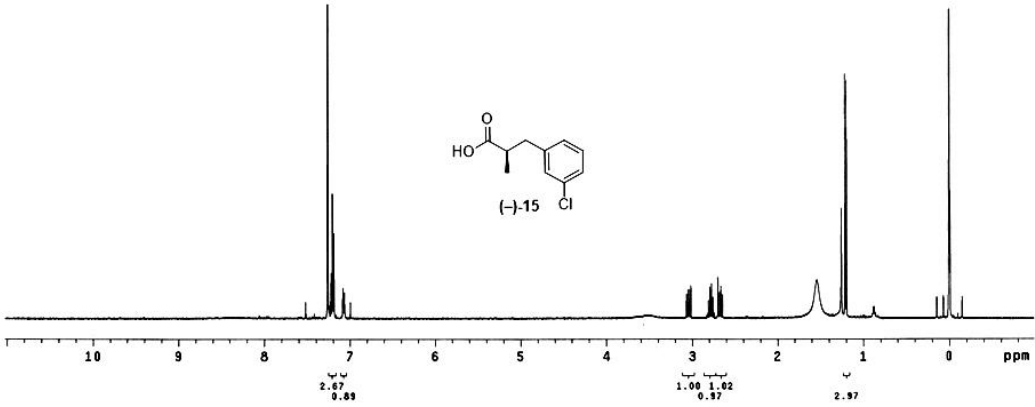
Figure 2. The NMR spectrum of crude ( − )- 15 obtained after cleavage in the sequential reactions using 2a .